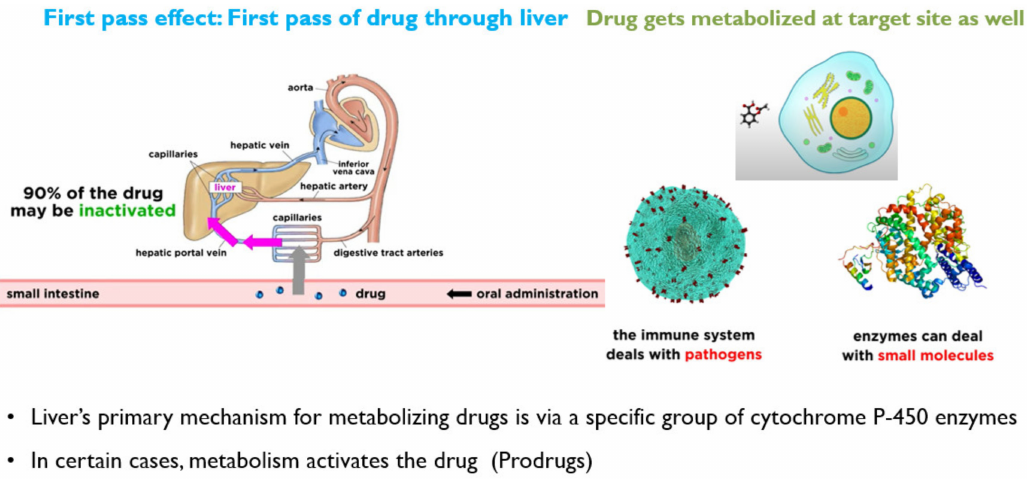
Figure 13. Schematic of drug metabolism in the liver as well as the